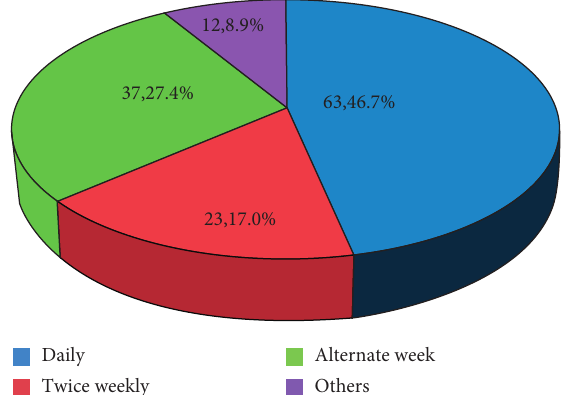
Figure 1: Frequency of treatment of critical illnesses in partici- pants’ clinical practice.